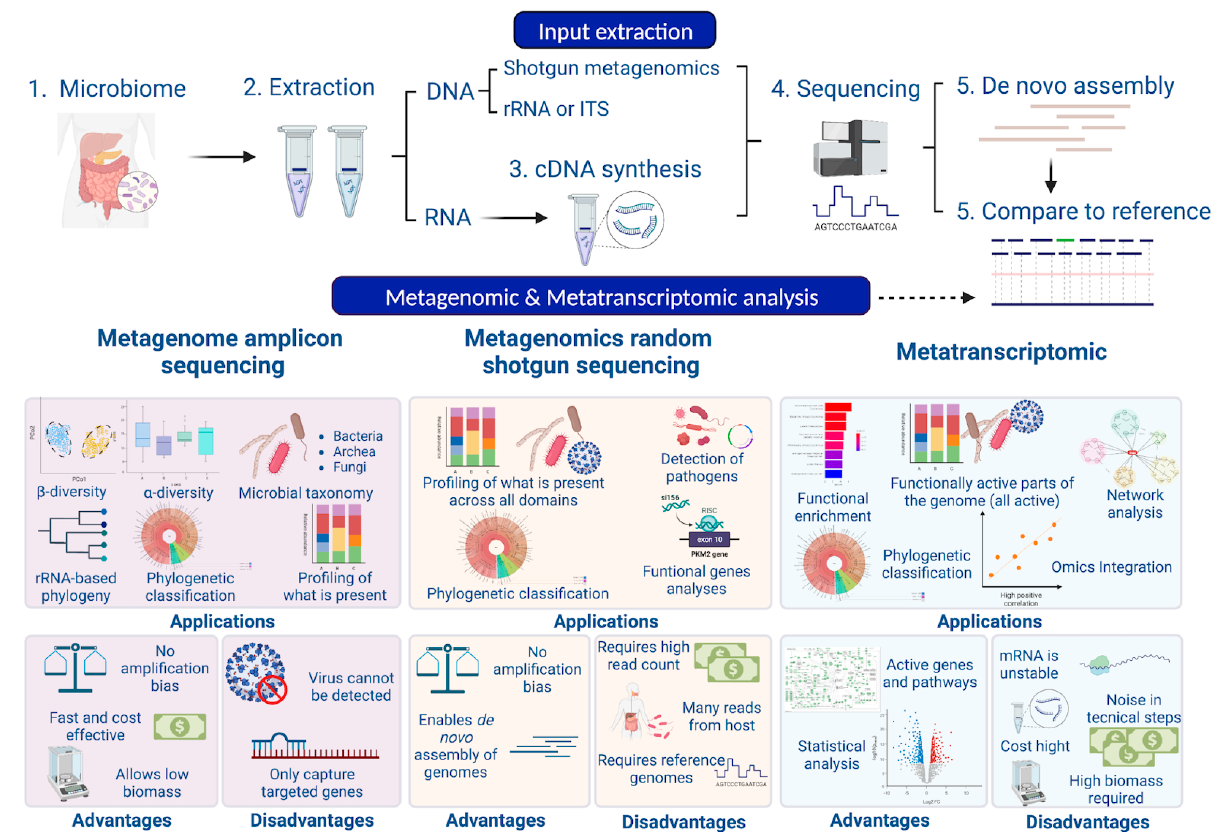
Figure 2. Workflow of a metagenomic analysis: laboratory and bioinformatic analysis . 16S rRNA/mRNA/DNA is extracted. Subsequently, they are sequenced. The raw data files are processed using different protocols. On the one hand, de novo assembly can be performed for unknown se- quences. On the other hand, samples can be processed directly using different tools. The advantages and disadvantages of the different methodological approaches are presented. Figure created with BioRender.com. BioRender.com accessed on 17 October